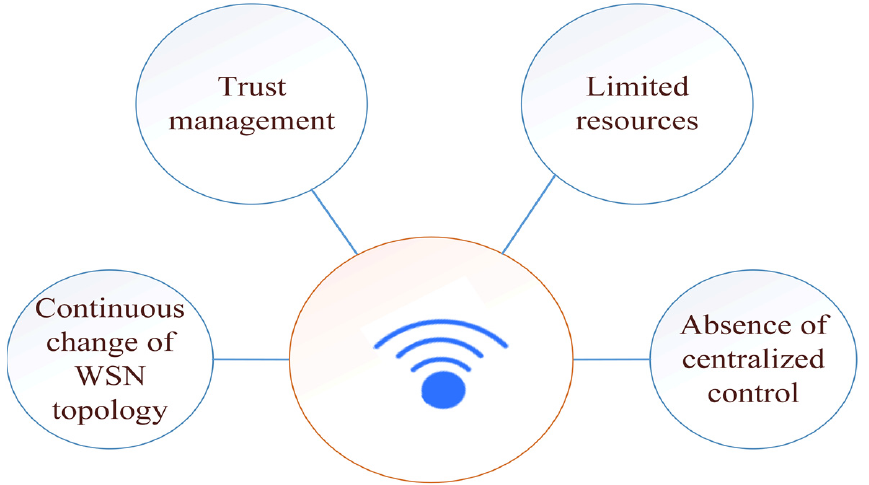
Figure 11. WSN’s main security challenges.